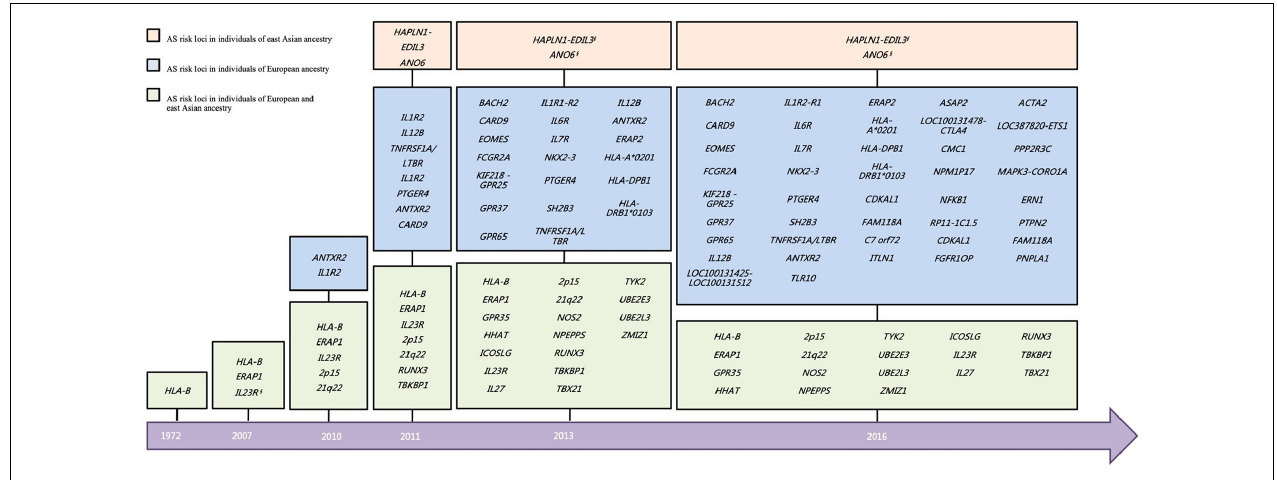
FIGURE 2 | Historical overview of disease susceptibility polymorphisms identified in AS. Risk loci selected with a genome-wide significance threshold of P < 5 × 10 − 7 as well as secondary associations ( P < 5 × 10 − 4 after conditioned for the primary associated SNP), in the previous studies are included. *But different SNP. § No independent support for the two loci in other East Asian cohort. AS, ankylosing